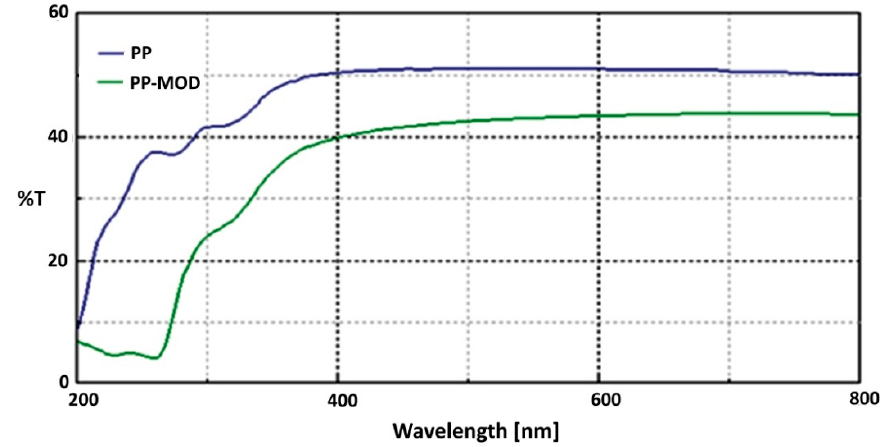
Figure 4. Comparison of transmittance spectra (%T) in the range λ = 200–800 nm of polypropylene nonwoven samples without (PP) and with L-Ala-Ala P modifier (PP-MOD).